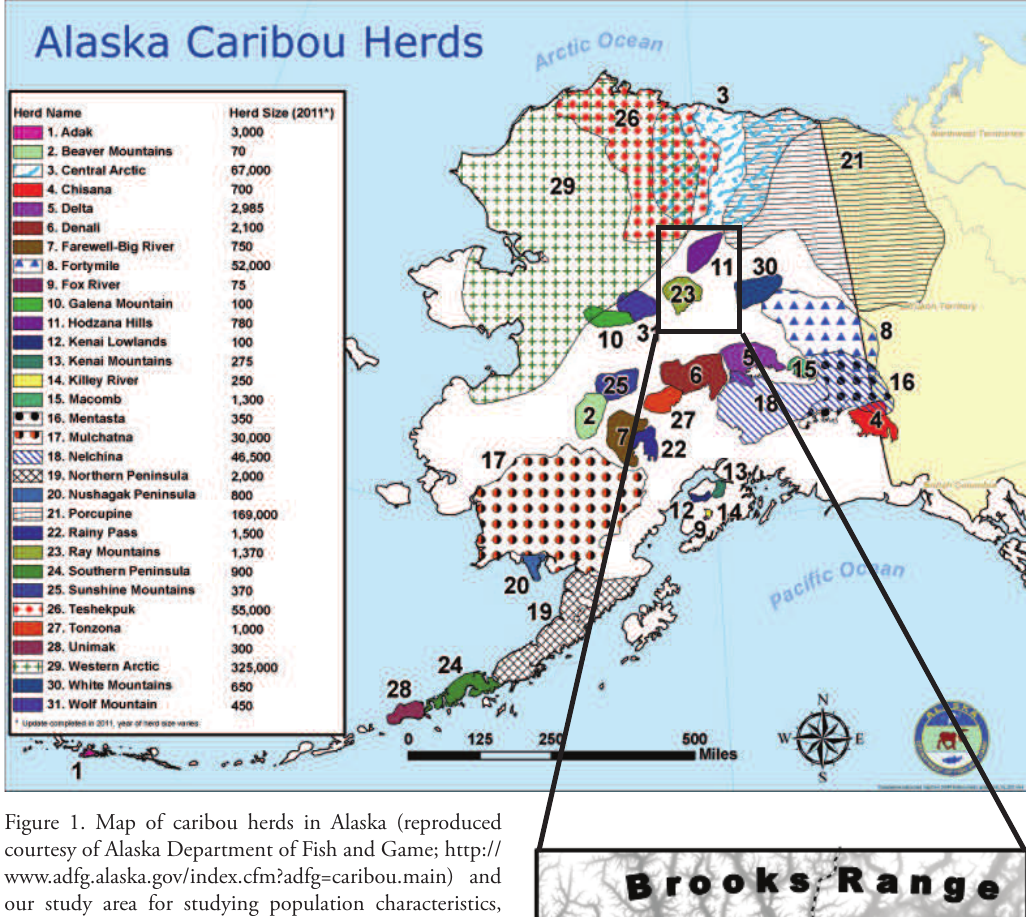
Figure 1. Map of caribou herds in Alaska (reproduced courtesy of Alaska Department of Fish and Game; http:// www.adfg.alaska.gov/index.cfm?adfg=caribou.main) and our study area for studying population characteristics, distribution, and habitat selection of 2 non-migratory caribou herds in the Hodzana Hills and Ray Mountains. Lighter shading indicates higher